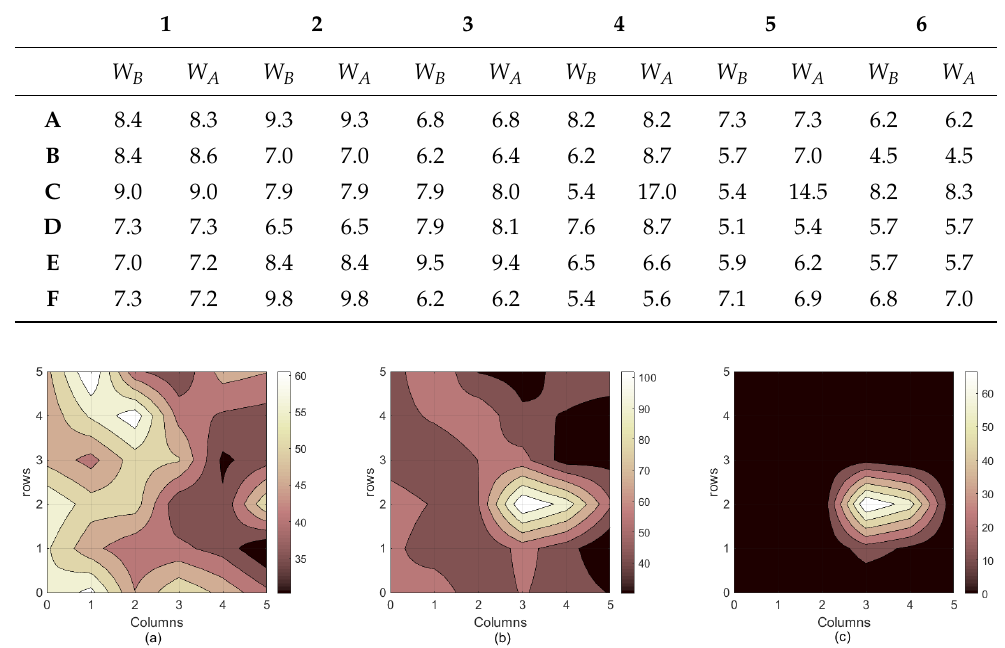
Figure 16. 2D mapping of moisture dynamics in soil: ( a ) W B , ( b ) W A and ( c ) W A − W B .